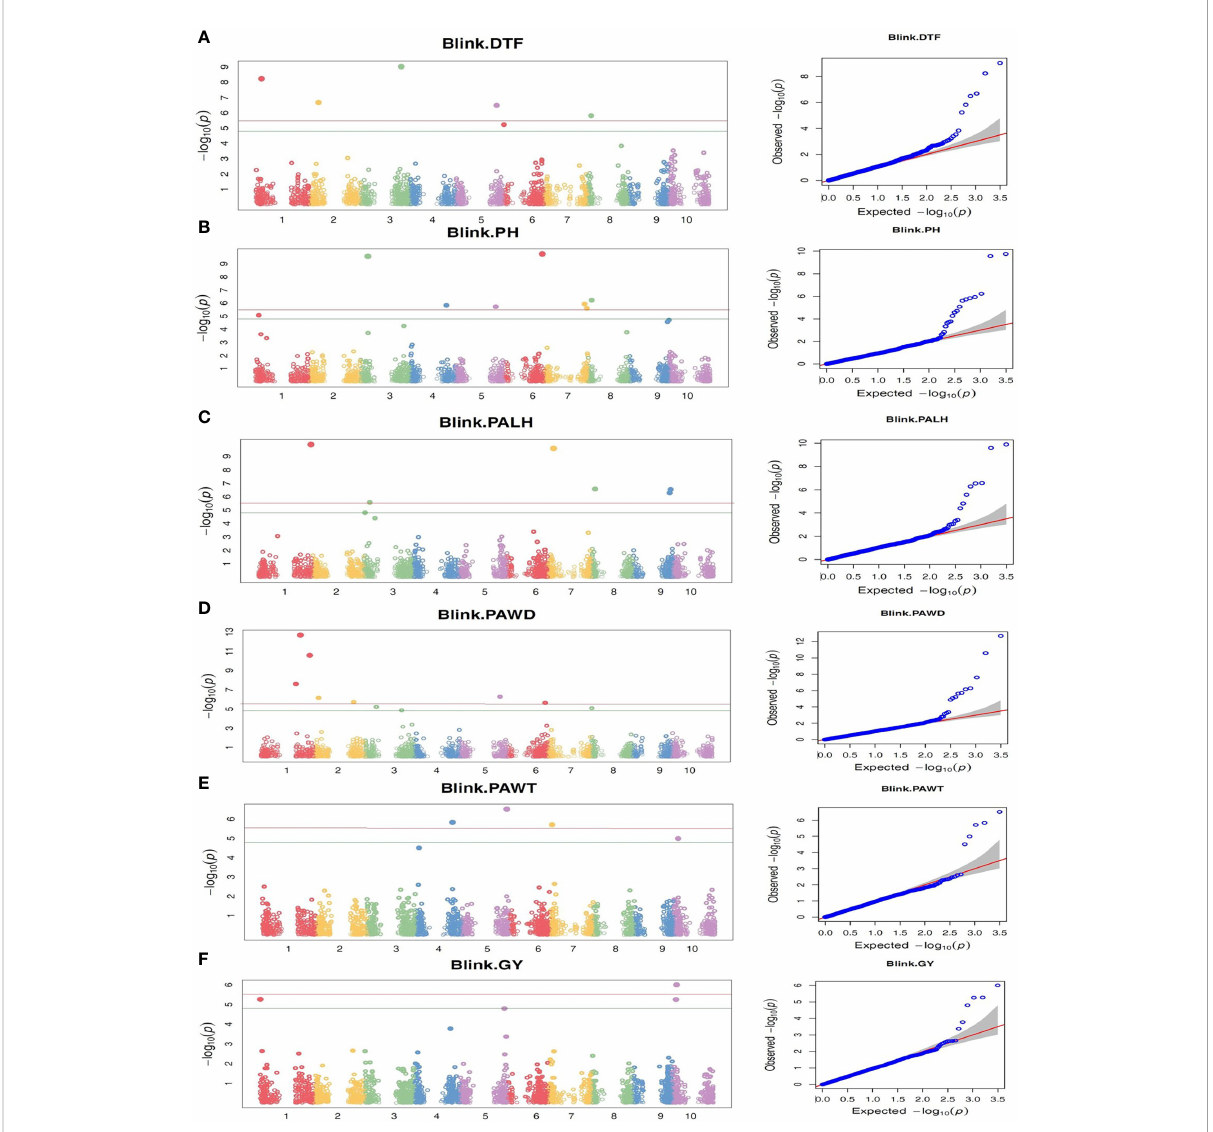
FIGURE 5 The Manhattan and QQ plots from BLINK-based GWAS analyses of 309 Ethiopian sorghum accessions using 3143 genome-wide SNP markers, revealing markers with signi fi cant association (P-value threshold of 0.05 with Bonferroni correction) with the traits targeted in this study. (A) DTF, Days to fl owering; (B) PH, Plant height; (C) PALH, Panicle length, (D) PAWD, Panicle width, (E) PAWT, Panicle weight, and (F) GY, Grain yield. The horizontal red and green lines represent P-value threshold of 0.01 and 0.05 with Bonferroni correction,